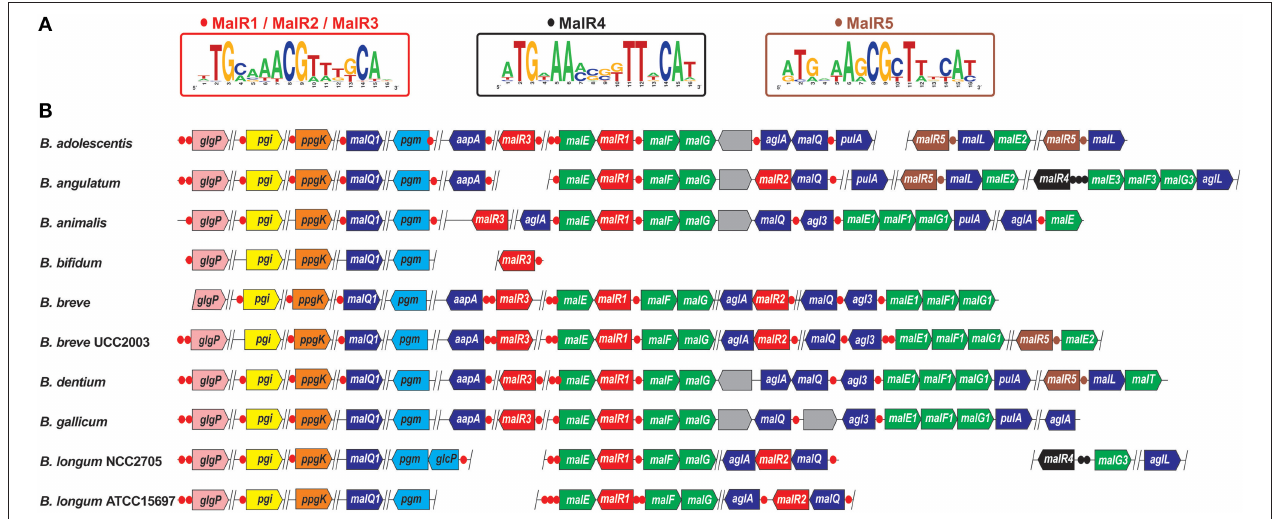
FIGURE 2 | Genomic organization of LacI-family regulons for maltose and maltodextrin utilization genes in bifidobacteria. (A) Consensus sequence logos for predicted DNA binding sites of five orthologous groups of MalR regulators. MalR1, MalR2, and MalR3 have identical DNA motifs. (B) Genomic context of MalR regulons in 10 Bifidobacterium genomes. Candidate regulator binding sites and genes from each regulon are shown by circles and arrows, respectively. Genes encoding MalR1/MalR2/MalR3, MalR4, and MalR5 regulators, as well as their cognate binding sites, are in red, black, and brown, respectively. Maltose/maltooligosaccharide ABC transporter genes malEFG/maEFG1/malE2/malEFG3 are in green. Glycosyl hydrolases involved in maltodextrin utilization are in dark blue (these functional roles are listed in Table S4). Glycogen phosphorylase glgP, glucose-6-phosphate isomerase pgi, glucokinase ppgK, and phosphoglucomutase pgm are in pink, yellow, orange, and light-blue, respectively. Genes of unknown function are in gray. Vertical lines separate operons that are not adjacent on the